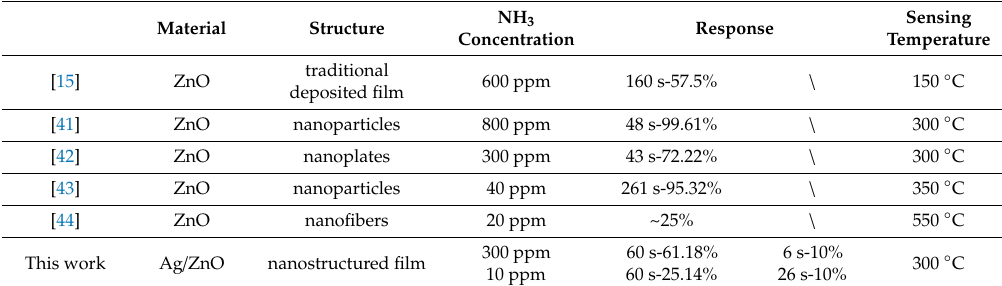
Table 1. The performance comparison of ZnO ammonia sensors.